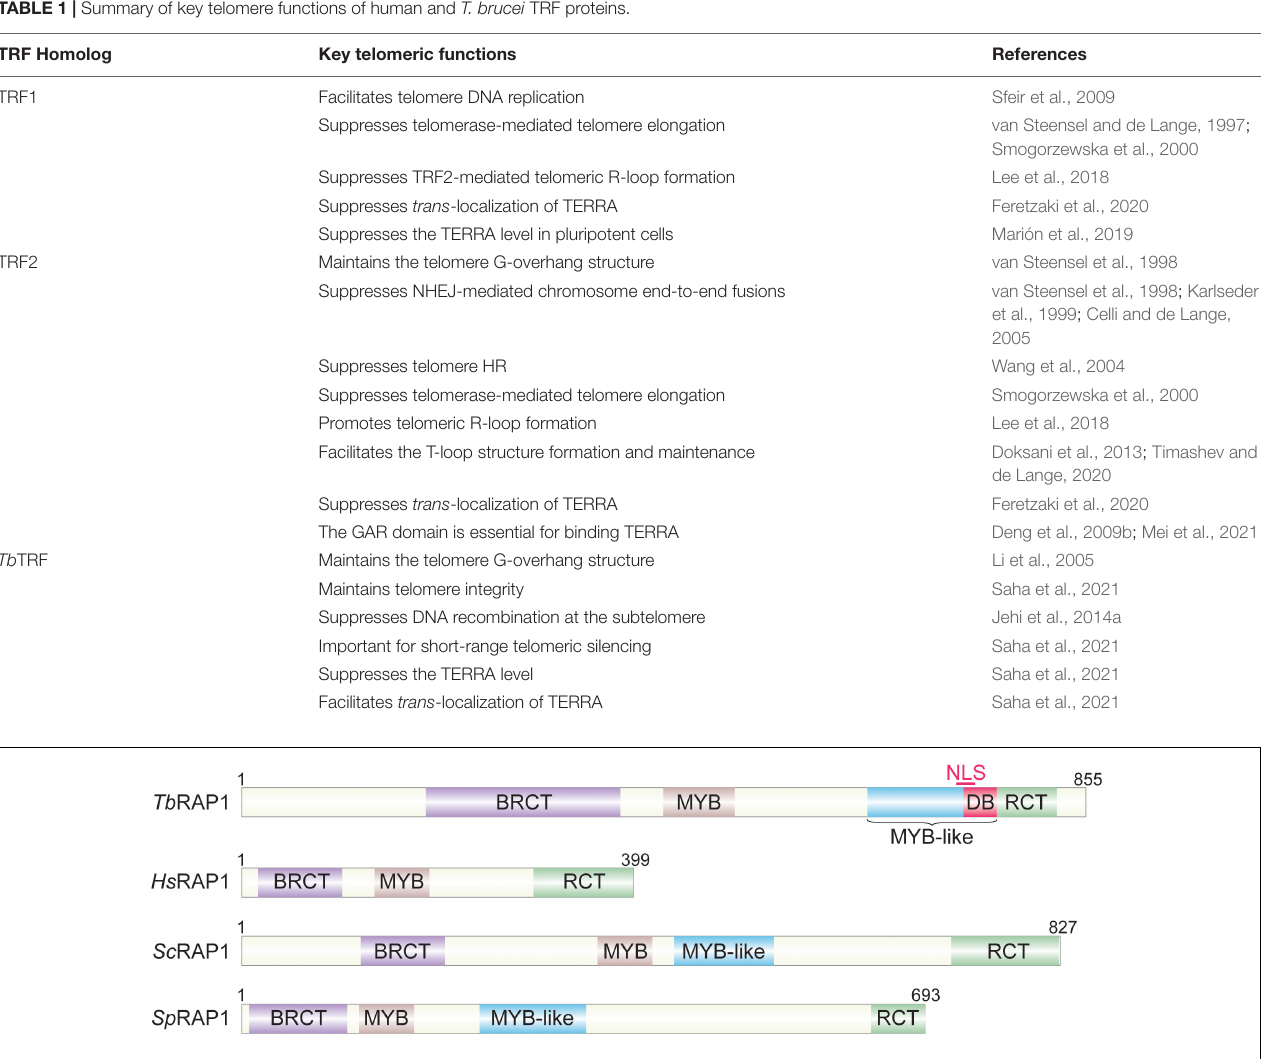
TABLE 1 | Summary of key telomere functions of human and T. brucei TRF proteins.